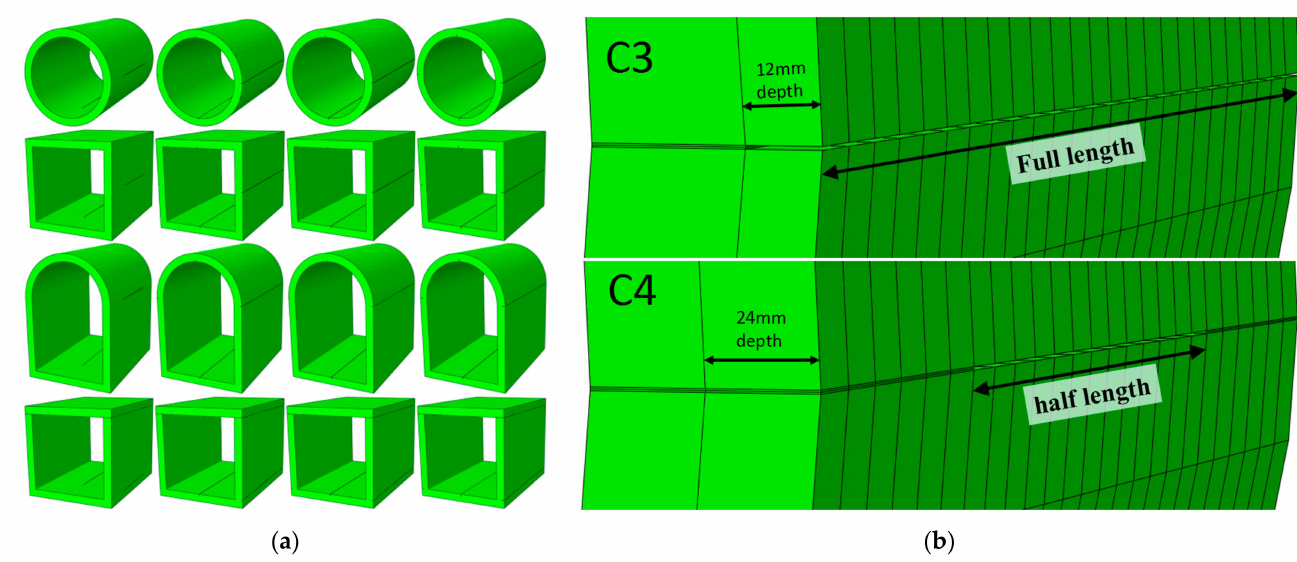
Figure 3. ( a ) FEM models of cracked cable tunnels and ( b ) detailed dimensions of